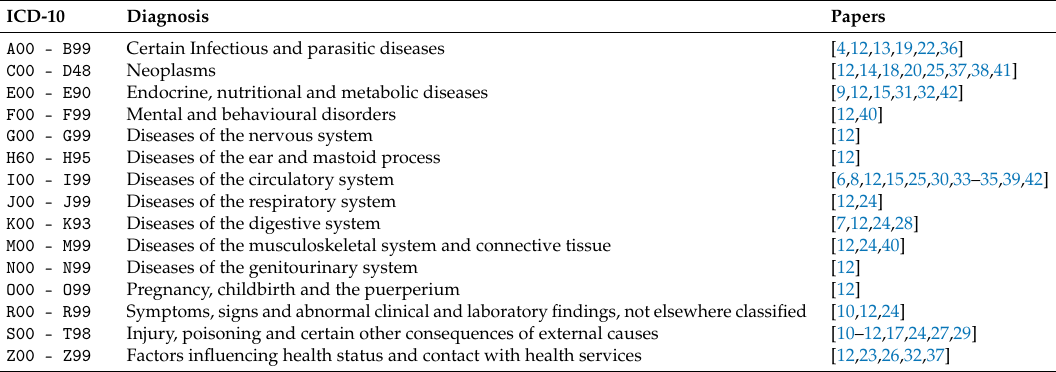
Table 6. Papers with their corresponding ICD-10 medical